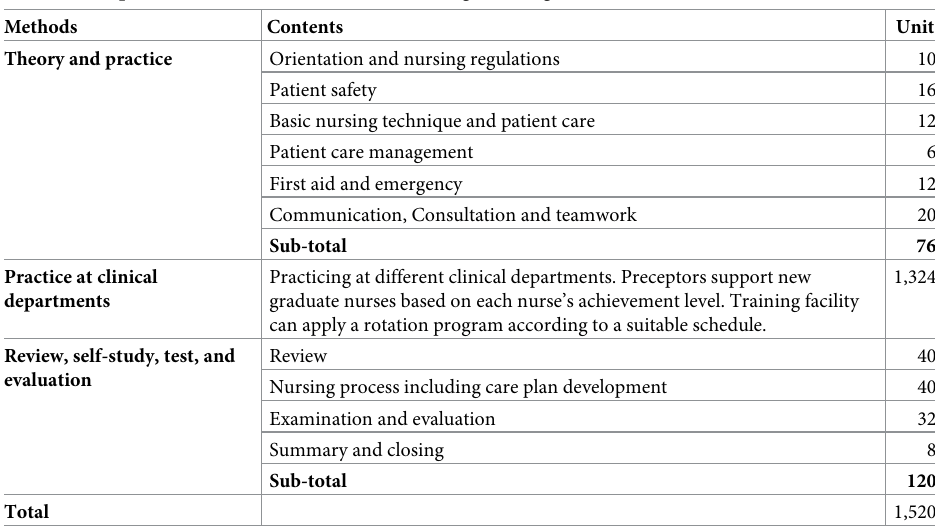
Table 1. Composition of curriculum for clinical training for new graduate